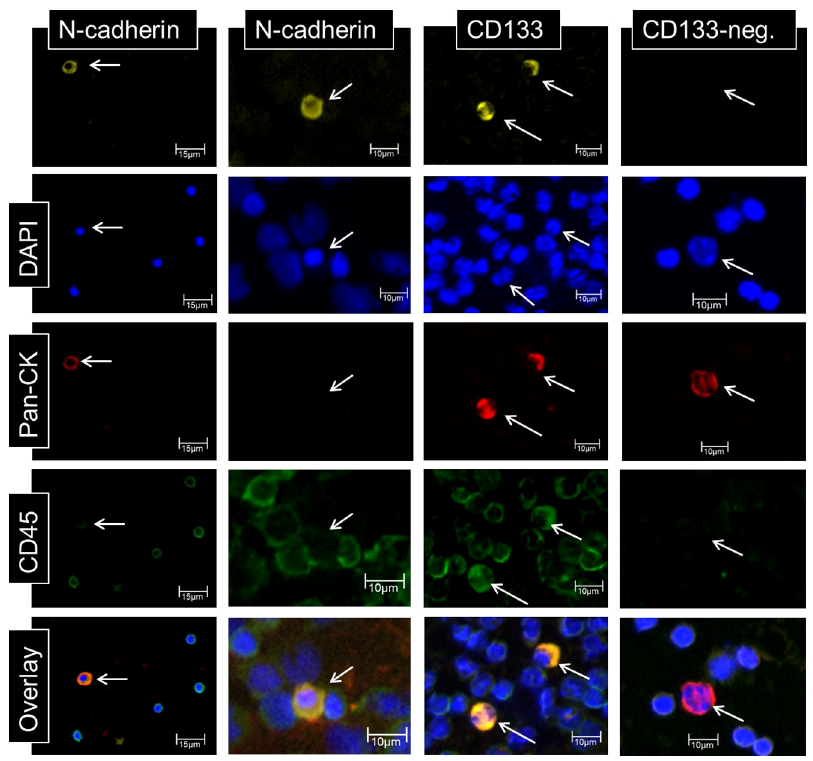
Figure 2. Selection of detected CTC subtypes using multi-immunofluorescence staining. As described above we detected a variety of CTC subtypes. N-cadherin and CD133 were stained on separate slides, respectively, together with CK, CD45 and DAPI. Pseudo colours were used to depict CTC subtypes: N- cadherin (mesenchymal,yellow); CD133 (stem-cell-like, yellow), pan-cytokeratin (CK; epithelial, red), CD45 (hematopoietic, green) and DAPI (nucleus, blue). We were able to detect cells with epithelial and mesenchymal properties like N-cad + /CK + /CD45low, as well as cells with mesenchymal features such as N- cad + /CK 2 /CD45low. We also observed cells showing mixed characteristics like CD133 + /CK + /CD45 + and cells with epithelial characteristics such as CD133 2 /CK + /CD45 2 cells. More CTC subtypes were detected, but are not shown in this